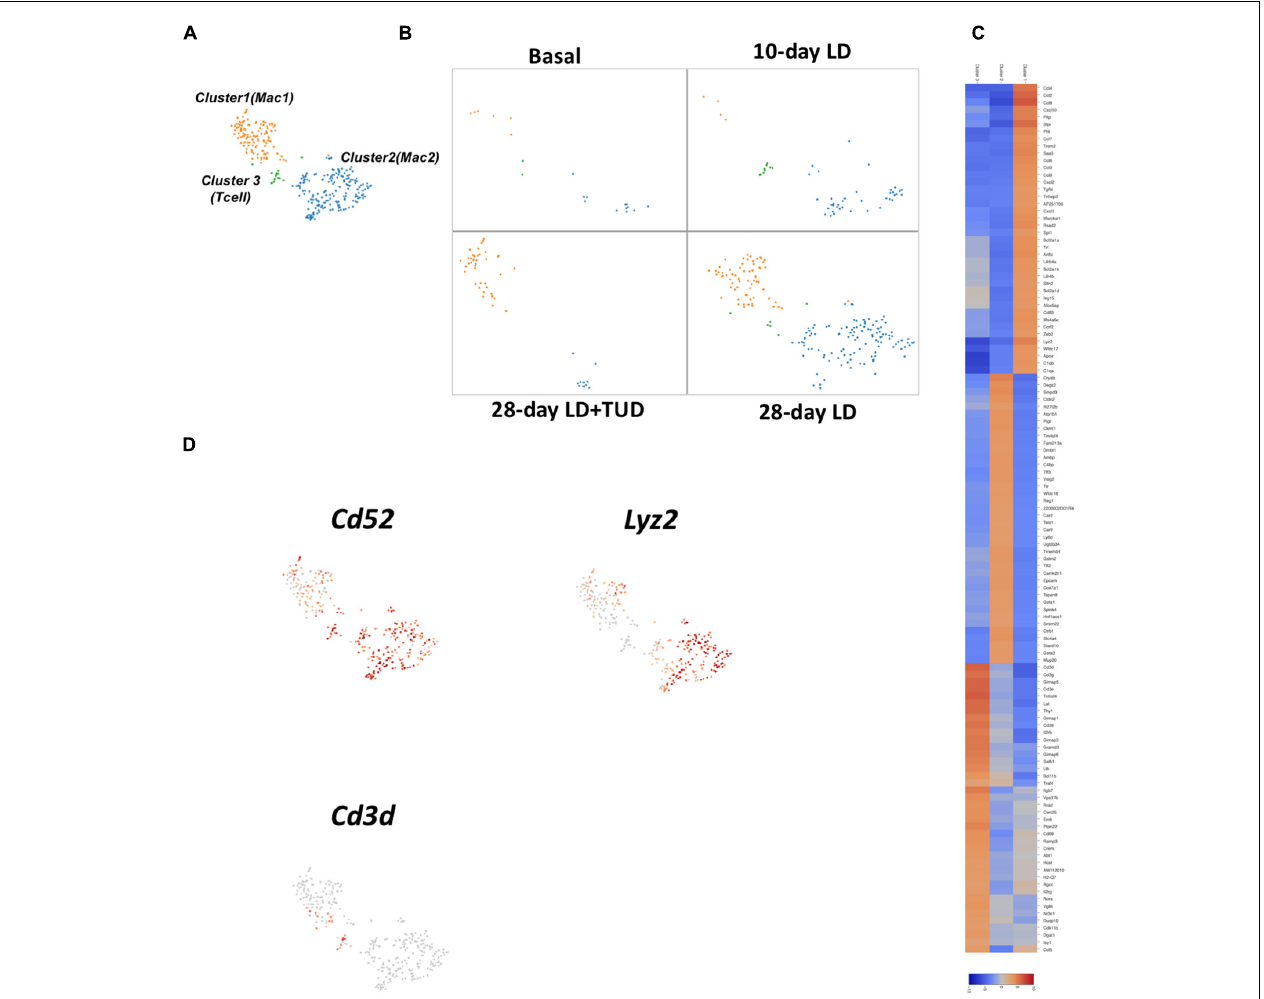
FIGURE 6 | Sub-clustering analysis of the transcriptome pattern of immune cells infiltrated in gallbladder wall. (A) t-SNE plot showing three major cell types of immune cells by sub-clustering analysis. (B) t-SNE plot showing the dynamic transcriptomic patterns of the immune cells during gallstone formation and TUDCA treatment. (C) The heatmap indicated enriched expressions of marker genes in each sub-cluster of immune cells according to their transcriptome pattern. (D) t-SNE plot highlighting the sub-clusters of immune cells according to representative markers. Clusters 1 and 2 expressed C52 Campath-1 antigen ( Cd52 ). Cluster 3 comprised of a small number of T-cells which expressed markers as Cd3d and Cd3e